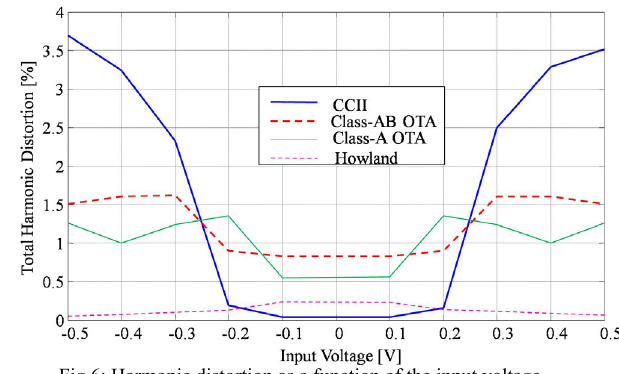
Fig.6: Harmonic distortion as a function of the input voltage.